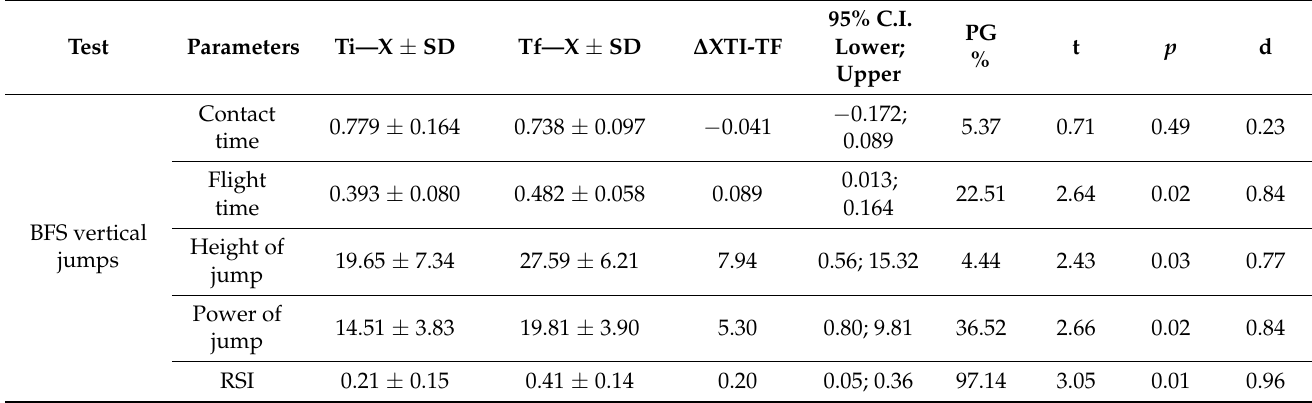
Table 5. Statistical description of the BFS vertical jump